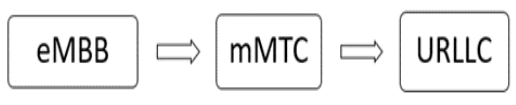
Figure 7. The top three cases of 5G uses